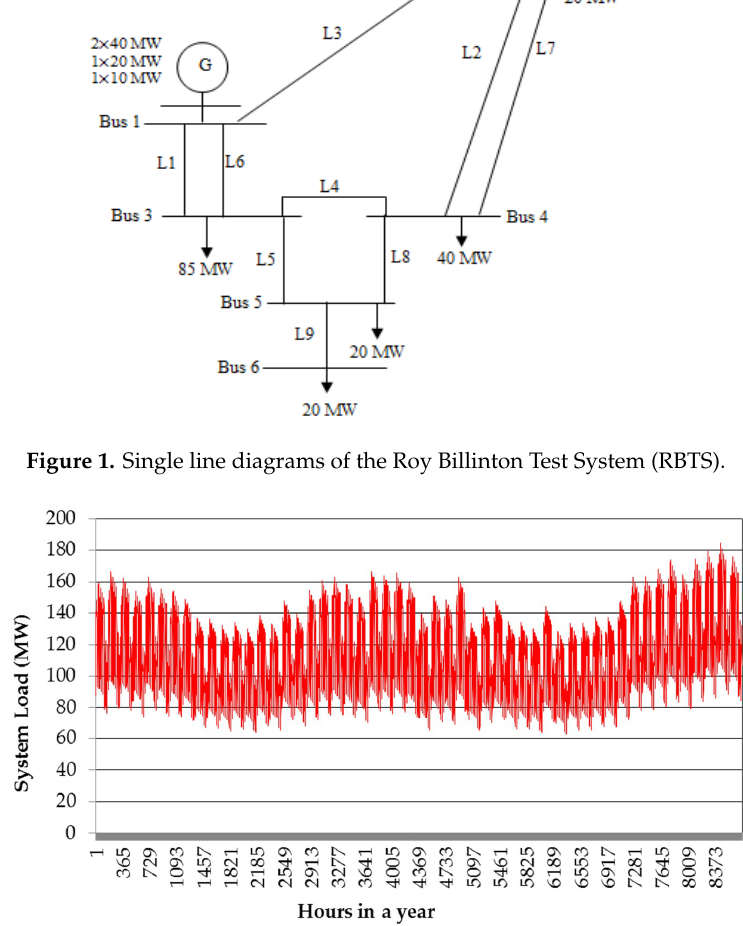
Figure 2. Chronological hourly load (Load Duration Curve (LDC)) model for the RBTS.